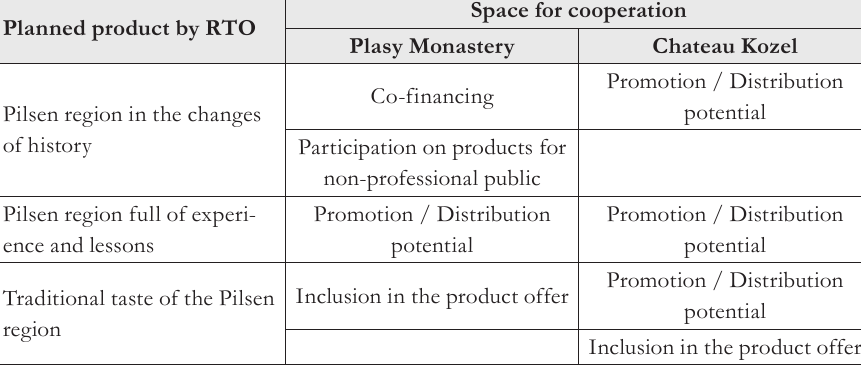
Tab. 4 - Cooperation suggestions. Source: Own creation Planned product by